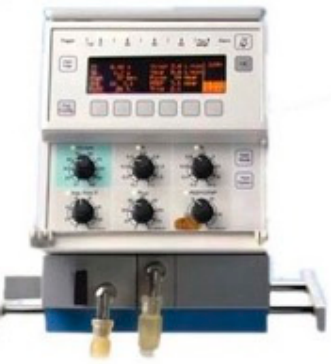
Figure 6. Neonatal ventilator.